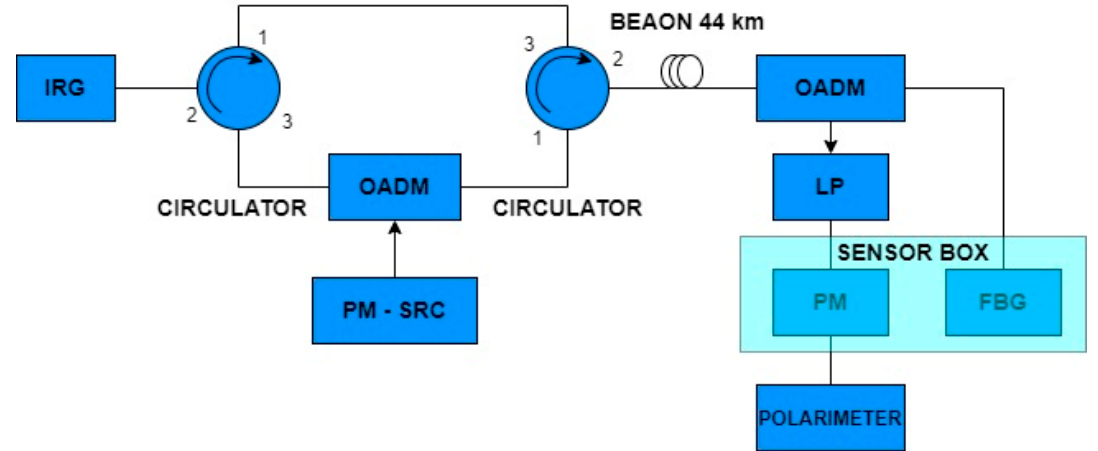
Figure 8. Basic wiring of a combined sensor that uses a single- fi ber polarization sensor, FBGs, and DWDM technology. IRG—interrogator, BEAON—Brno Experimental Academic Optical Network, LP—linear polarizer, OADM—optical add-drop multiplexer.